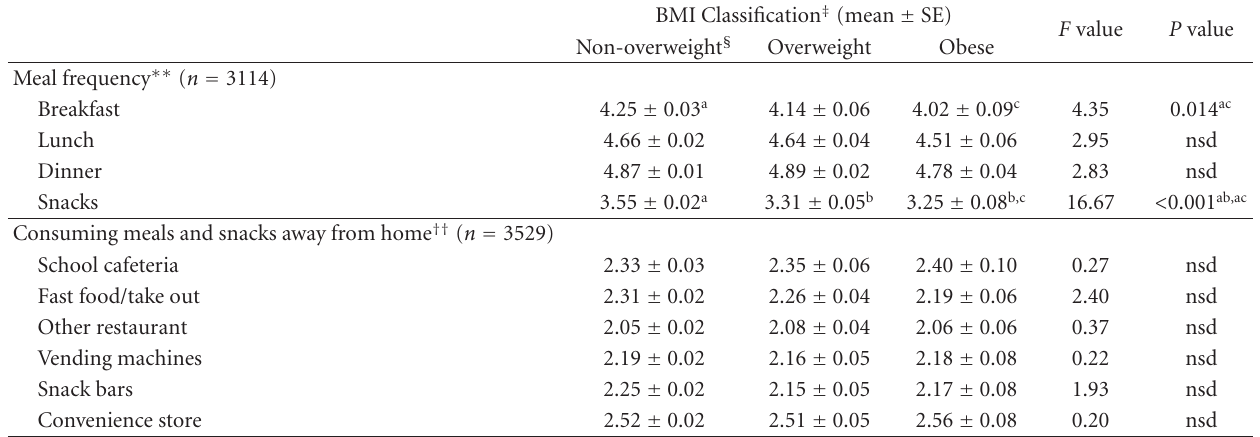
Table 3: Group di ff erences in suboptimal meal behaviours ∗ based on BMI classification † . BMI Classification ‡ (mean ±